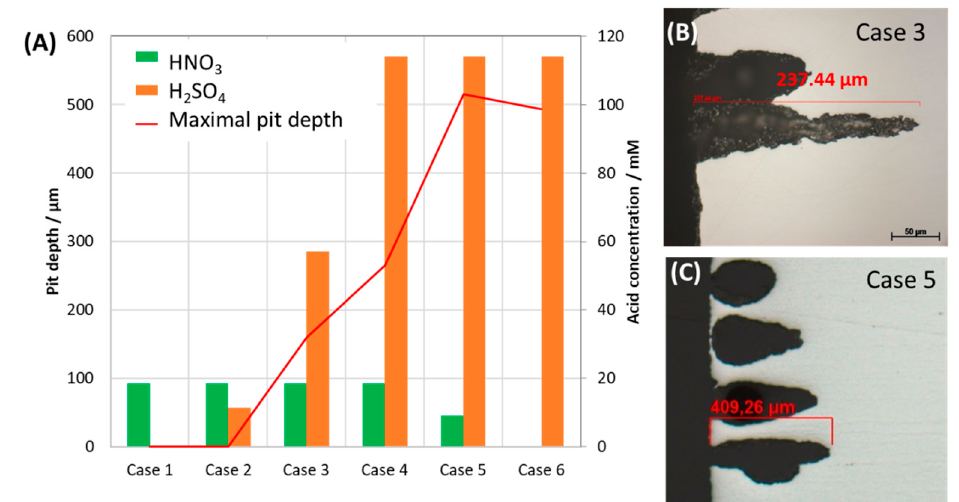
Figure 11. Effect of individual acid concentration on the maximal pit depth ( A ) of the exposed coupons and the cross-section images ( B , C ) of the 7-day exposed coupon, showing example of pit appearance. The condensates contained varied concentration of H 2 SO 4 and HNO 3.